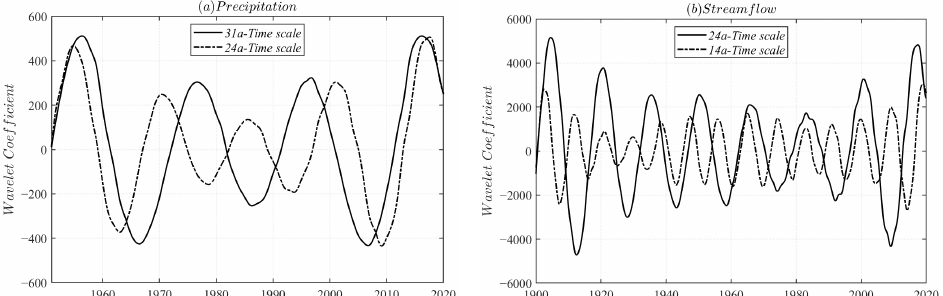
Figure 6. Wavelet coefficient processes of the first and second main cycles in annual precipitation and annual streamflow variations. ( a ) Precipitation (1951–2020); ( b ) Streamflow